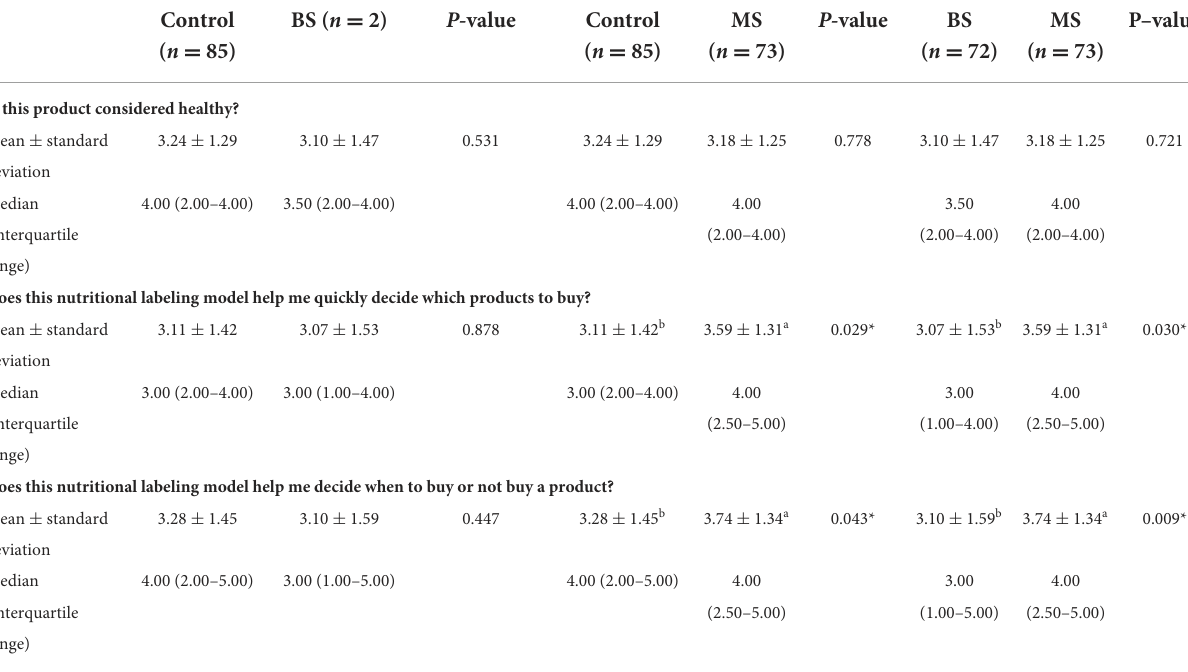
TABLE 8 Mean, median, and SD of the scale values, according to the different models of the study, for perceived healthiness of selected products, facilitation of a quick purchase decision, and decision of to buy or not to buy a product, based on the results obtained with the RotulApp